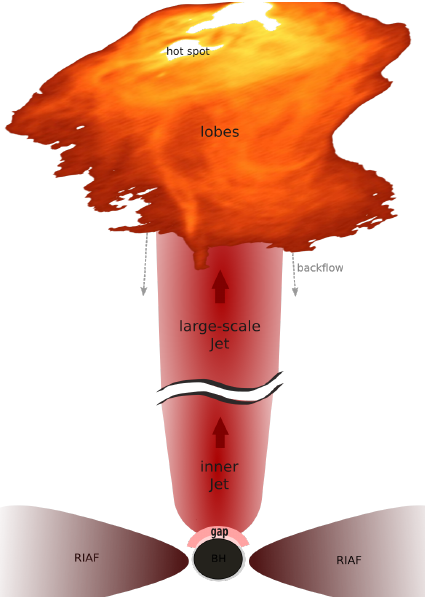
Figure 9. Sketch: Radio galaxies or jetted AGNs provide multiple sites for cosmic particle acceleration, from the black hole vicinity (gaps) to their large-scale lobes. The preferred acceleration mechanism can change, dependent on the location within the source. Some of the mechanisms might as well work in tandem as to UHECR production.